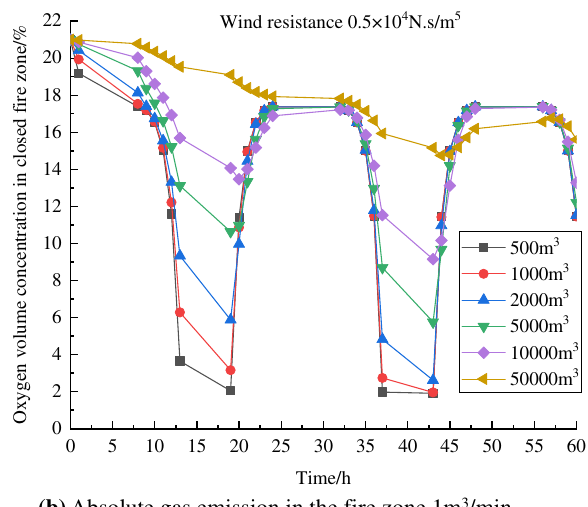
Fig. 4 Different gas emission, different fire zone volume, and small wind resistance, the oxygen concentration in the fire zone change with time after the completion of closure at 24:00 midnight are